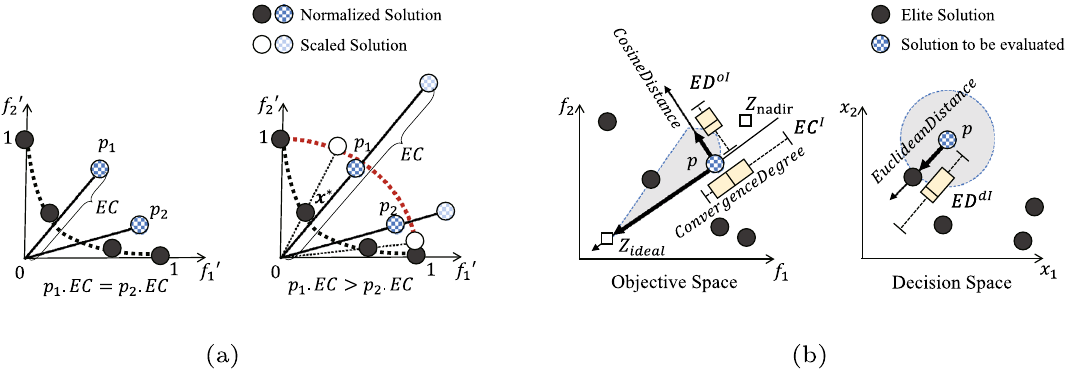
Fig. 1 Diagrams of basic concepts in RPE. a EC: the distance between an individual and a solution set. b Intervals in the objective space and the decision space over time